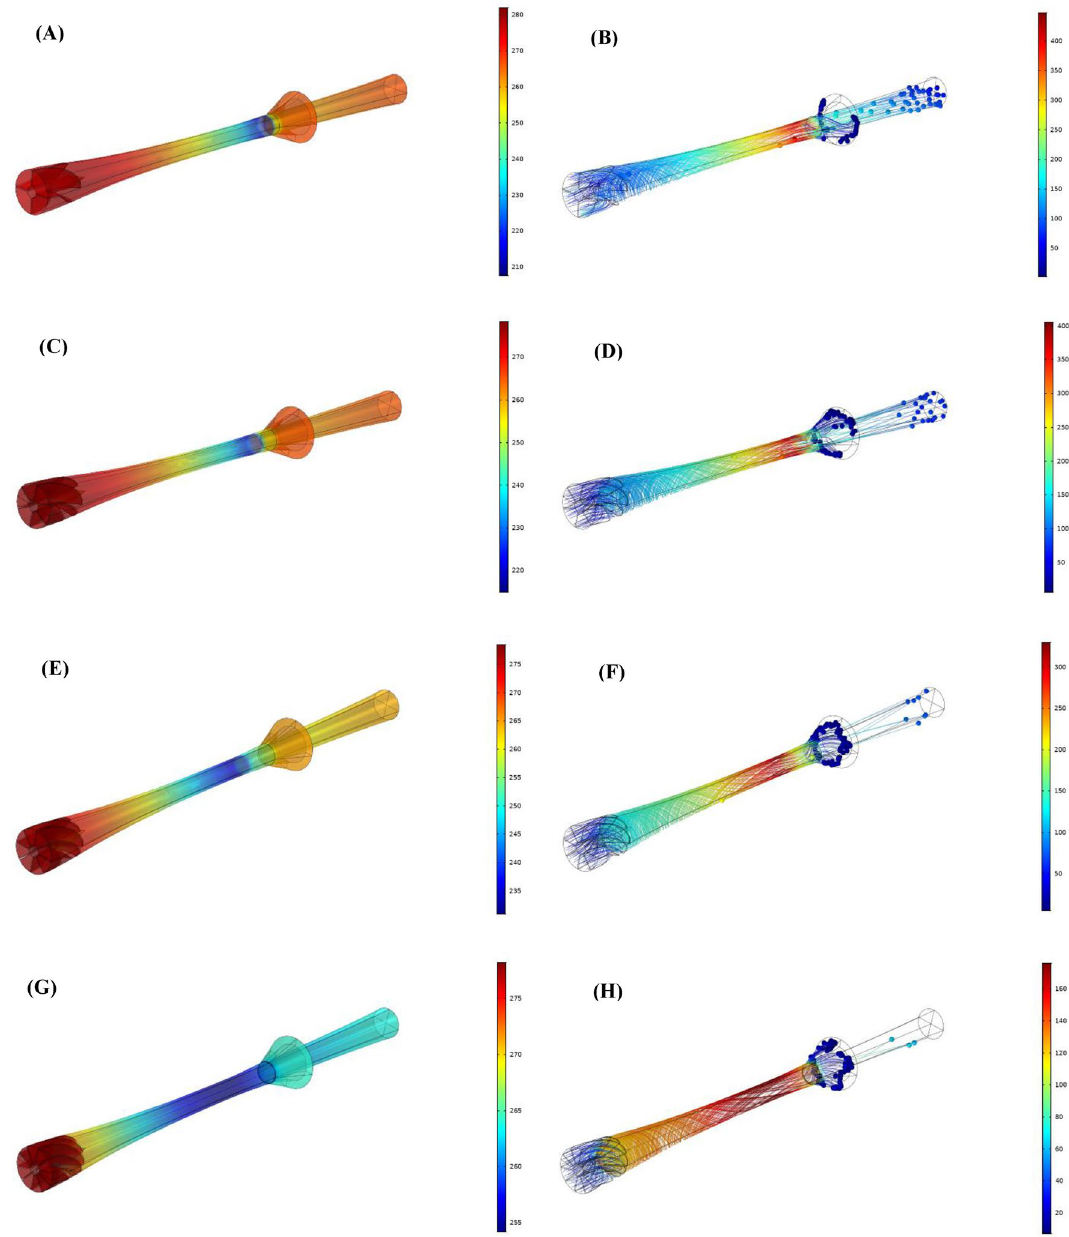
Figure 7. The influence of number of static vanes on the ( A, C, E and G ) temperature profile (K) and ( B, D, F and H ) liquid droplet behavior (dp = 2